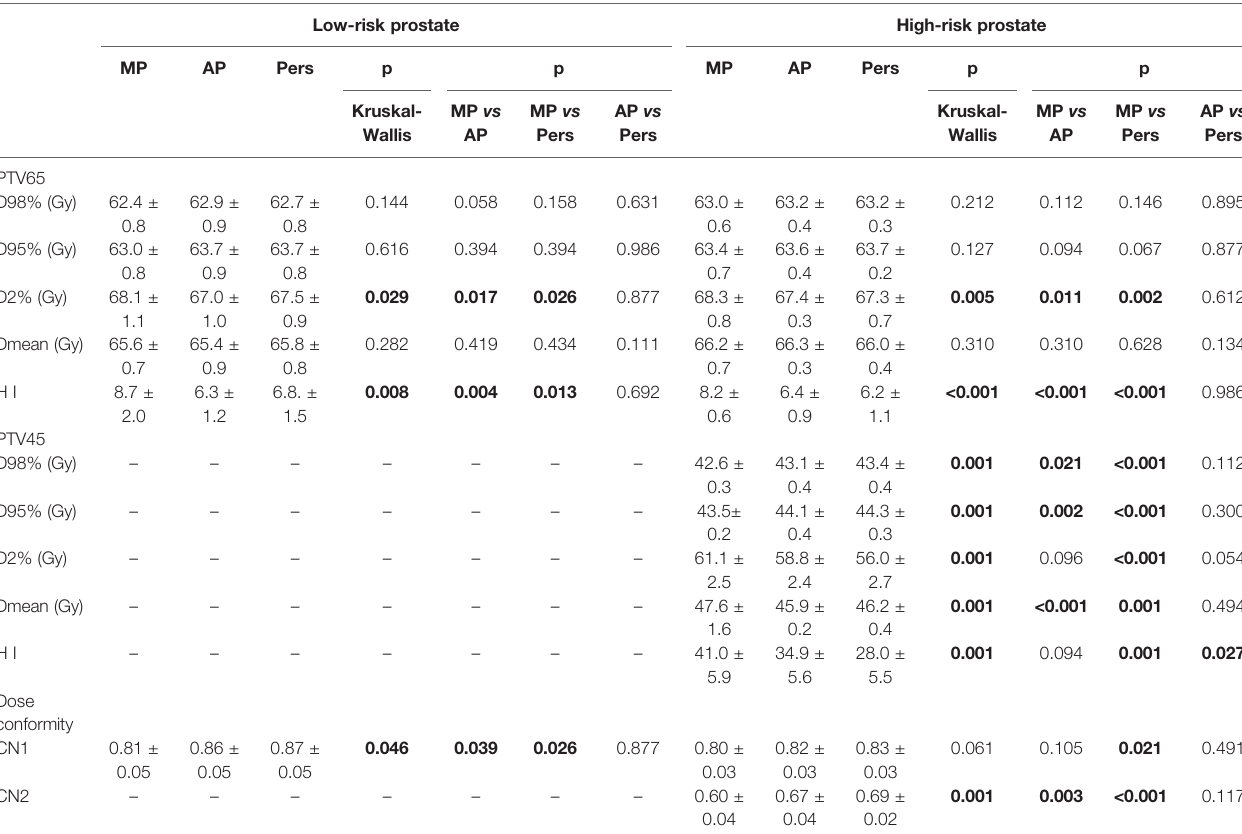
TABLE 3 | Comparison of dosimetric metrics between manual and automated plans for target volumes. Low-risk prostate High-risk